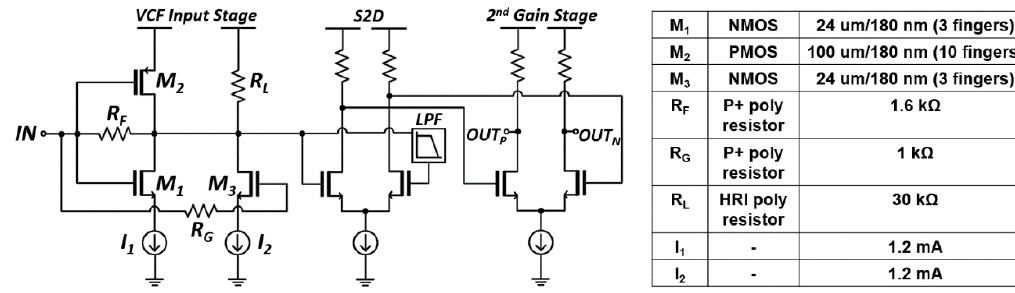
Figure 3. Block diagram of the proposed optoelectronic Rx IC.